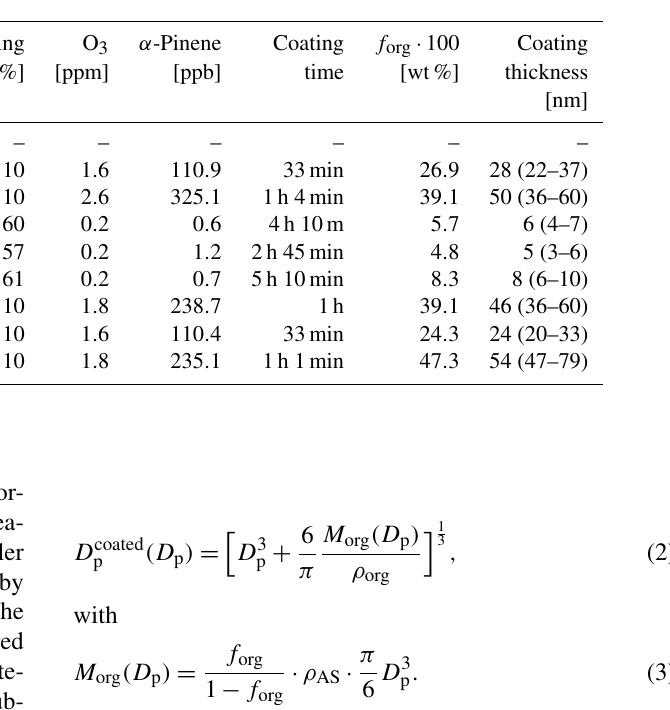
Table 1. Summary of the experiments performed and main parameters of the aerosol particle populations. D median p is the median diameter of the lognormal fit to the aerosol size distribution measured right before the coating procedure. The α -pinene concentration corresponds to the total amount added during the injection periods. For the in situ coating experiments (experiments type C), the organic mass fraction f org refers to the value measured at the end of the coating procedure. The coating thickness is estimated from a combined analysis of the SMPS and the AMS data – the first number refers to the coating thickness evaluated at the median diameter and the range in the parenthesis to the values at 300 and 500nm particle diameter (see text for more